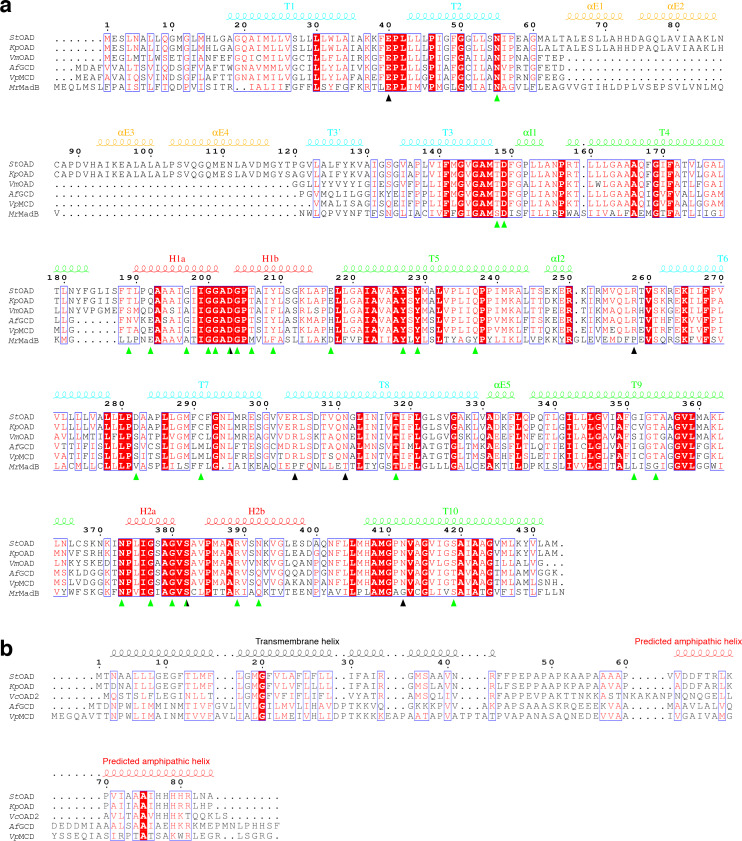
Sequence alignment of the OAD β (a) and γ (b) subunits and their equivalents in other decarboxylase sodium pumps.Residues numbers and secondary structure elements for the Salmonella typhimurium OAD (StOAD) are shown. Secondary structure elements for the β subunit are colored as in Figure 1. The black and green triangles indicate residues characterized by our study and previous studies on the Klebsiella pneumonia OAD (KpOAD), respectively. The predicted amphipathic helix at the C-terminal region of the γ subunit is indicated in red. VmOAD, Vibrio mediterranei OAD; AfGCD, Acidaminococcus fermentans GCD; VpMCD, Veillonella parvula MCD; MrMadB, Malonomonas rubra MadB; VcOAD2, Vibrio cholerae OAD isoform 2.